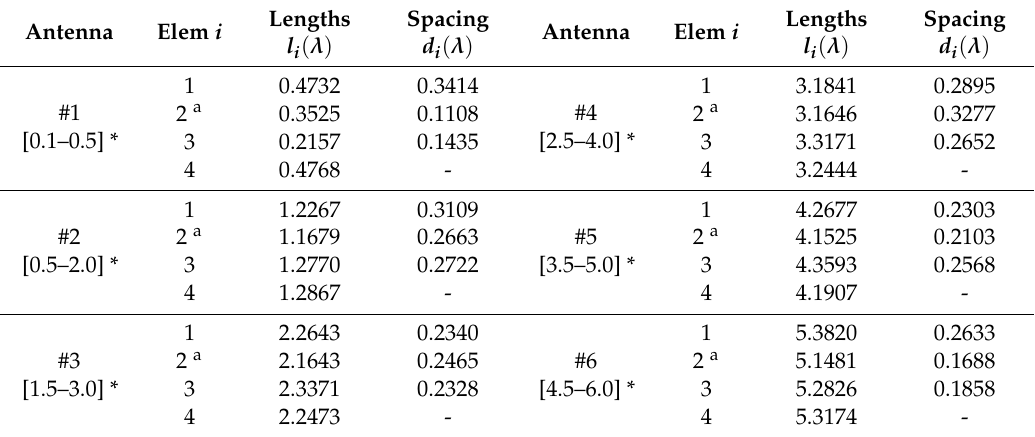
Table 2. Lengths and spacings of the relevant antennas based on the Yagi–Uda structure (described in Figure 1A) with four